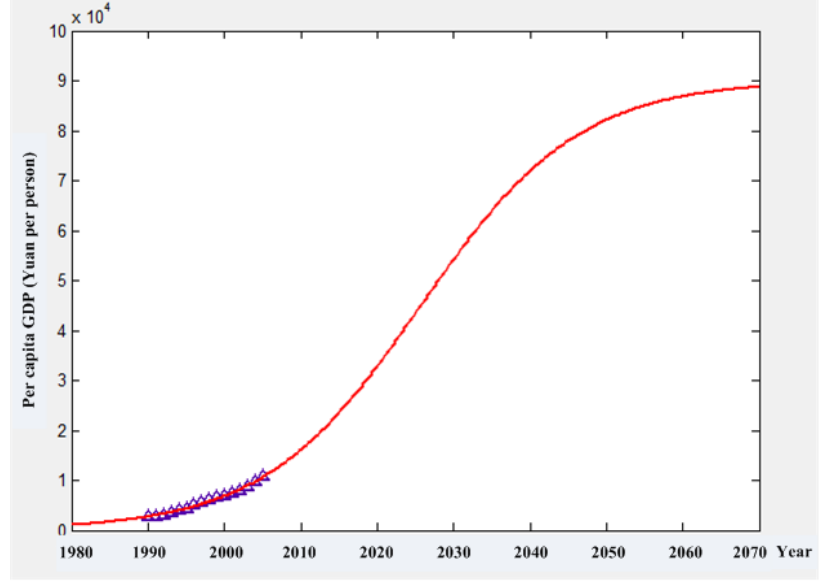
Figure 9. Fitting result of GDP per capita with the logistic curve